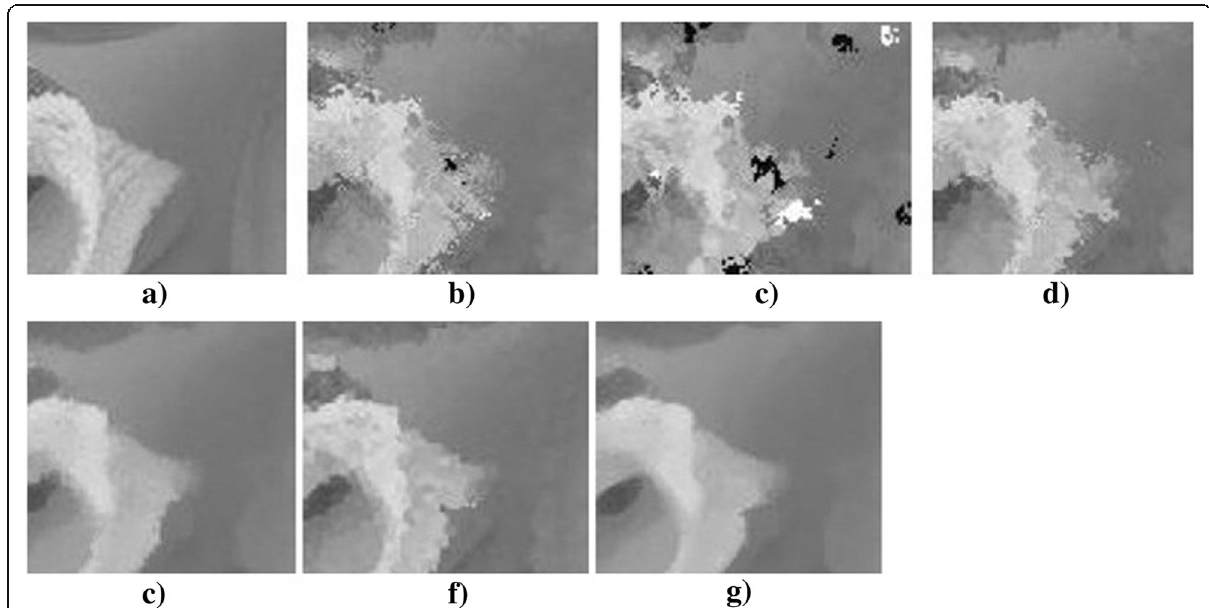
Fig. 9 Zoomed results with 90% impulsive noise. a Original image. b AMF. c AWMF. d Bhateja [20]. e SAMF. f Bhadouria [21]. g Proposed